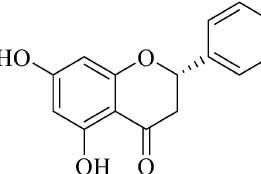
Figure 2. Steric configuration of (S)-pinocembrin or (S)-5,7-dihydroxy-2-phenylchroman-4-one.